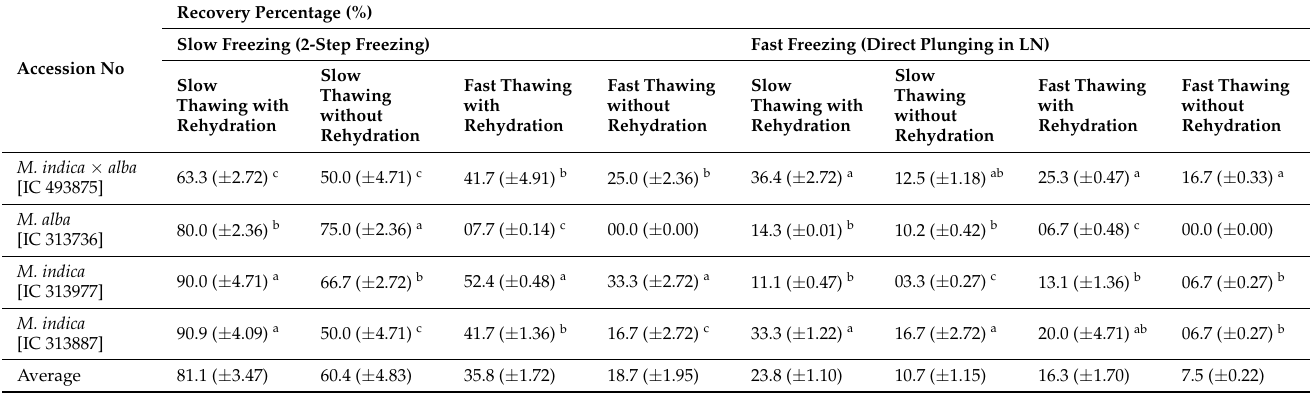
Table 2. Recovery percentage for dormant buds of different Morus species cryoconserved using slow and fast freezing after partial desiccation with and without rehydration.